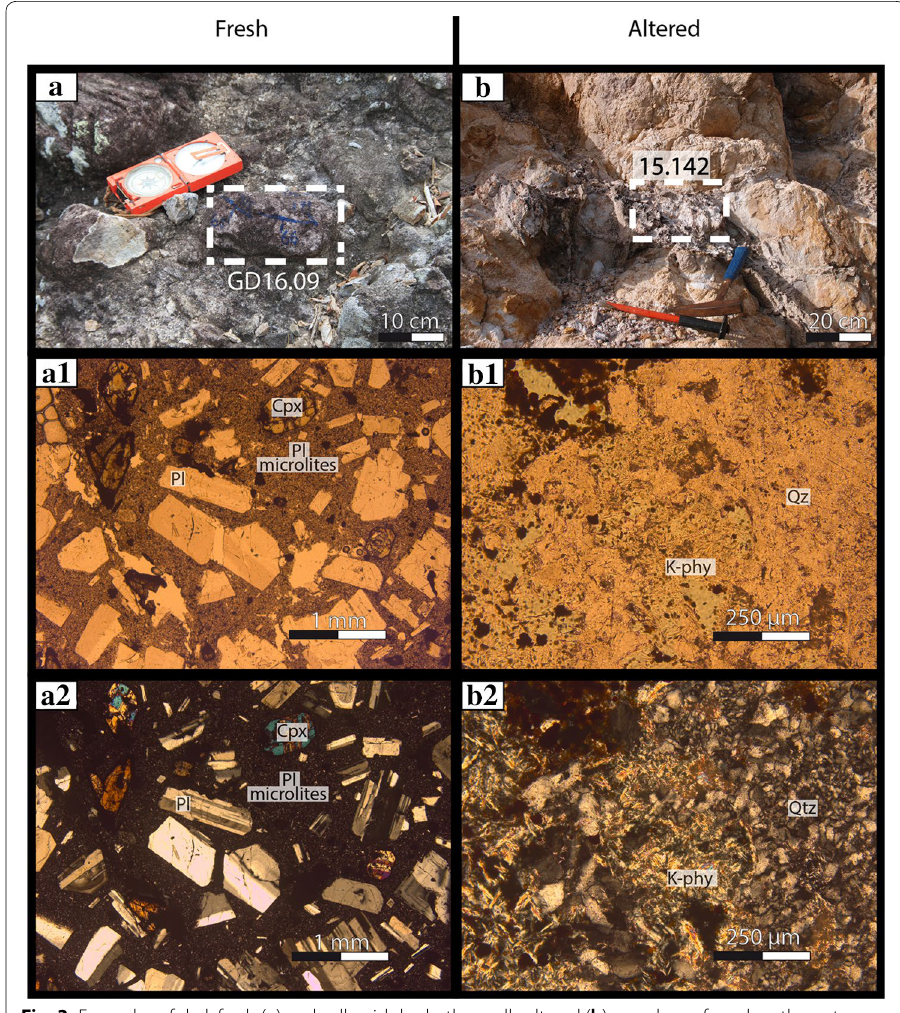
and corresponding thin sections seen by optical microscopy with plane polarized light ( a1 and b1 ) and crossed polarized light ( a2 and b2 ). Sample A corresponds to a clast in a debris flow while B sample was extracted from a fracture. Thin section of fresh sample A shows a rock in which the primary volcanic minerals and texture are preserved. Phenocrysts are euhedral but fractured (see also Fig. 4). Plagioclase (Pl) displays clear twins and clinopyroxene (Cpx) shows its normal birefringence. The groundmass is composed of µm-sized plagioclase microlites. Sample B seen in thin section shows a strongly transformed texture in